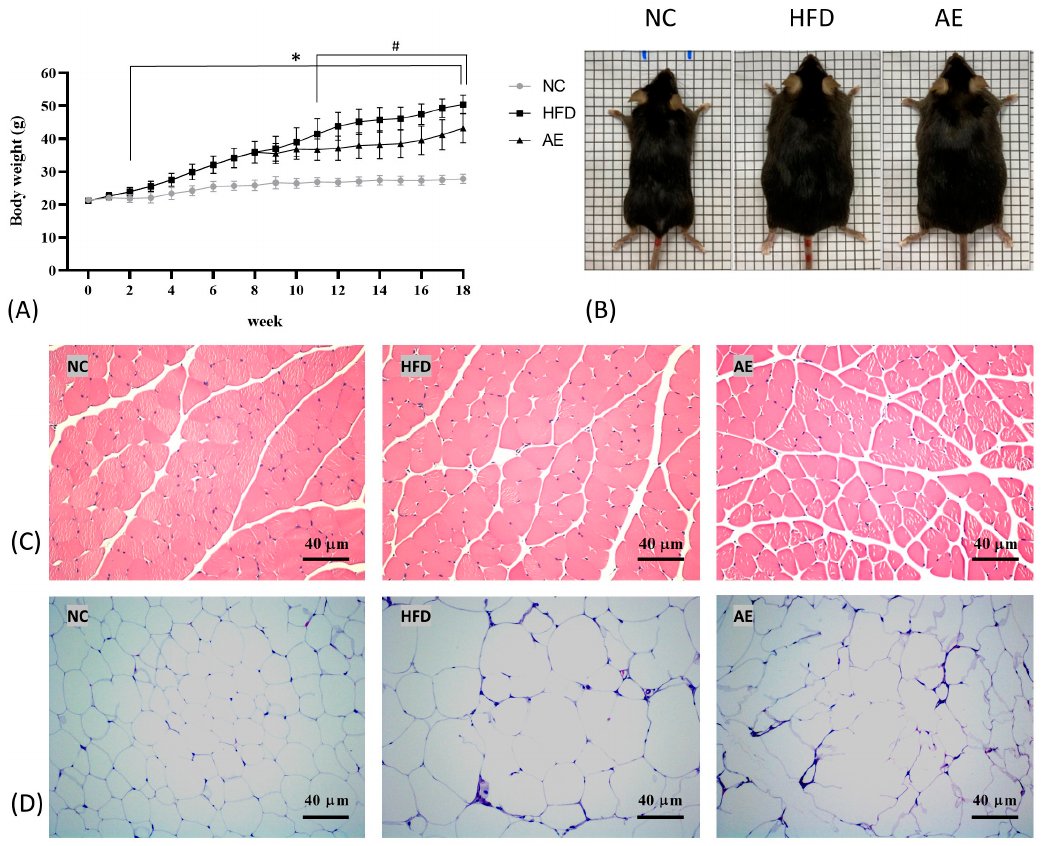
Figure 1. Effect of aerobic exercise on body weight ( A ), gross appearance of mice ( B ), morphology of skeletal muscle ( C ), and epididymal fat pad ( D ). Specimens were photographed using light microscopy (H&E stain, magnification: × 200, scale bar = 40 µ m) (* p < 0.05 HFD vs. NC group, # p < 0.05 AE vs. HFD group).